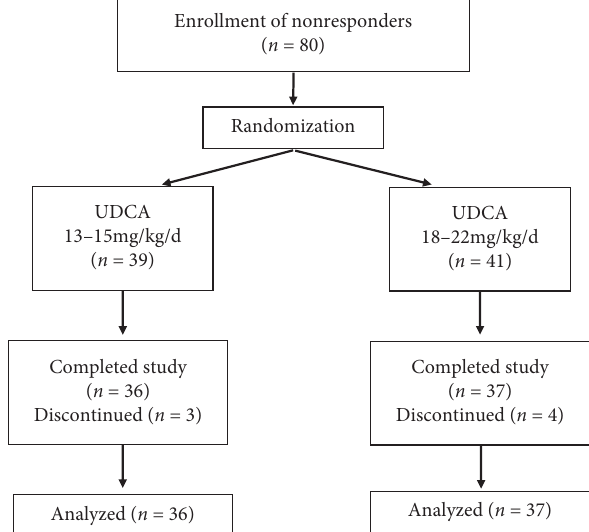
Figure 1: Flowchart of the Table 1: Characteristics of study population at entry.